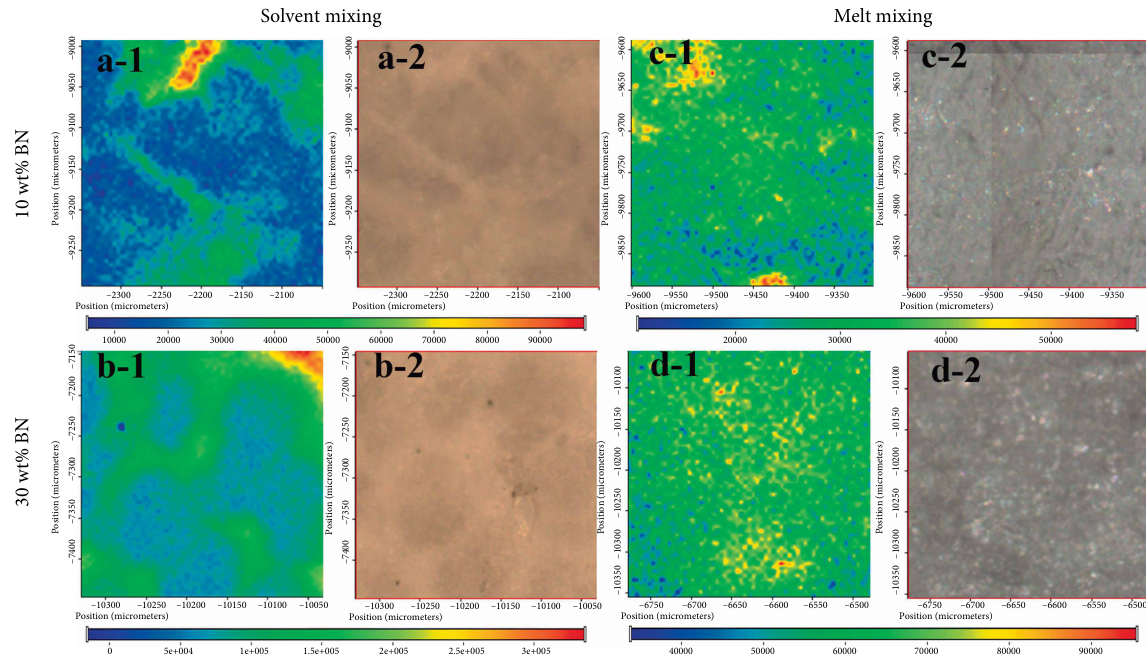
Figure 3: Raman Mapping of UHMWPE/BN composites by solvent mixing and melt